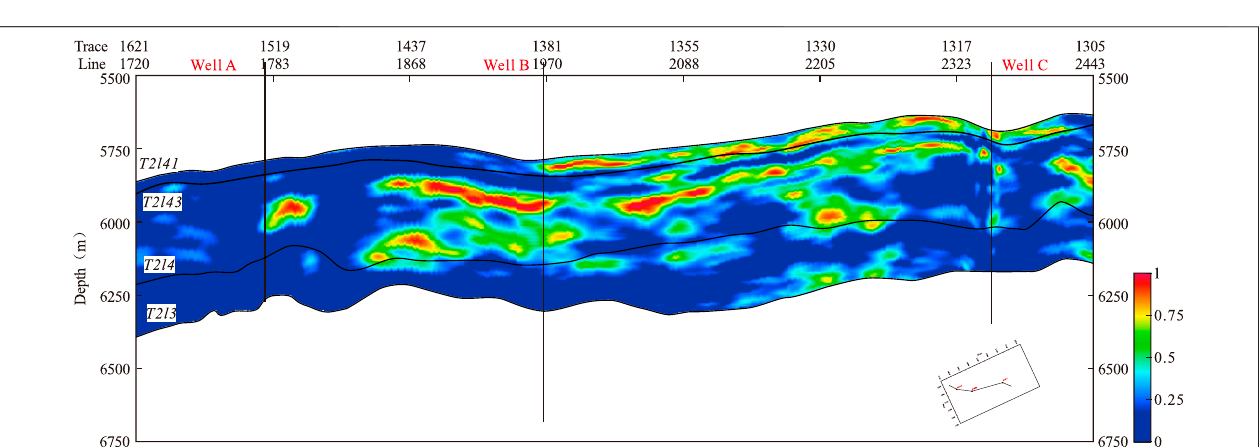
FIGURE 13 | Prediction results of depth threshold dispersion hydrocarbon.